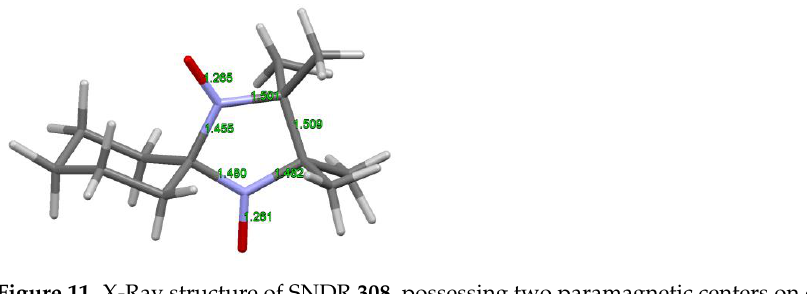
Figure 11. X-Ray structure of SNDR 308, possessing two paramagnetic centers on one carbon atom. A similar approach was employed to synthesize a related SNDR based on a cyclic ketone, 5α-cholestan-3-one [25].